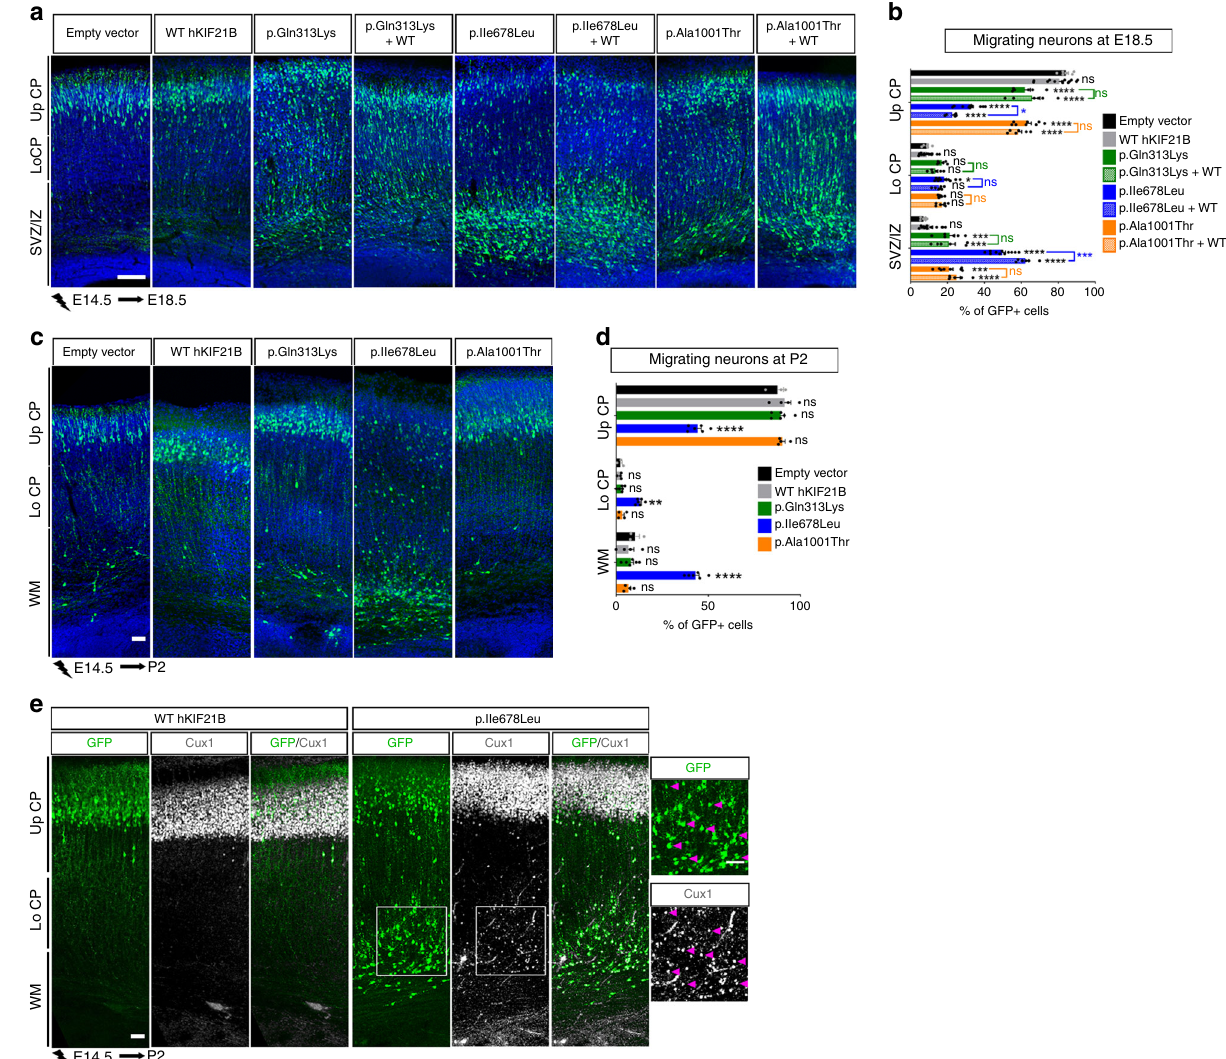
Fig. 3 Expression of h KIF21B missense variants induces abnormal neuronal migration. a , c Coronal sections of E18.5 ( a ) or P2 ( c ) mouse cortices electroporated at E14.5 with NeuroD-IRES-GFP empty vector (1 µ g/ µ L) or WT, p.Gln313Lys, p.Ile678Leu or p.Ala1001Thr NeuroD-hKIF21B or co-expressing WT-hKIF21B together with mutated hKIF21B constructs (ratio 1:1). GFP-positive electroporated cells are depicted in green. Nuclei are stained with DAPI. b , d Analysis (means ± S.E.M.) of the percentage of electroporated GFP-cells in different regions (Up CP: upper cortical plate, Lo CP: lower cortical plate, IZ: intermediate zone, SVZ: subventricular zone) showing effect of expressing hKIF21B variants. Data were analyzed by two-way ANOVA (Bonferroni ’ s multiple comparisons test). Number of embryos analyzed: b Empty vector, n = 6; WT, n = 13; p.Gln313Lys, n = 6; p.Ile678Leu, n = 11; p.Ala1001Thr, n = 8. Rescue experiments: n = 6 for each condition. d Empty vector, n = 3; WT, n = 4; p.Gln313Lys, n = 6; p.Ile678Leu, n = 6; p.Ala1001Thr, n = 4. ns non- signi fi cant; * P < 0.05; ** P < 0.005; *** P < 0.001; **** P < 0.0001. e Cux1-immunolabeling (gray) of P2 coronal sections of mouse brains electroporated at E14.5 with the WT or p.Ile678Leu NeuroD-hKIF21B constructs showing no speci fi cation defects of arrested neurons (green). Scale bars ( a , c , e ) 50 μ m. Source data are provided in the Source Data fi